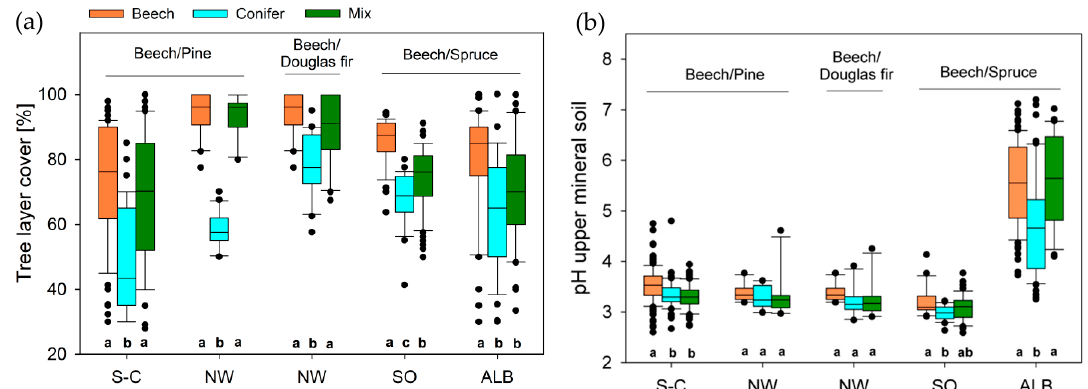
Figure 2. ( a ) Tree layer cover and ( b ) soil pH for pure and mixed stands sampled in four regions across Germany. Diagrams are arranged according to the considered tree species combination. Tree layer cover is based on the number of vegetation survey plots listed in Table A1. Soil pH is based on the following sample sizes: S-C: beech n = 139, pine n = 60, mix n = 76; NW (both combinations): n = 10 per